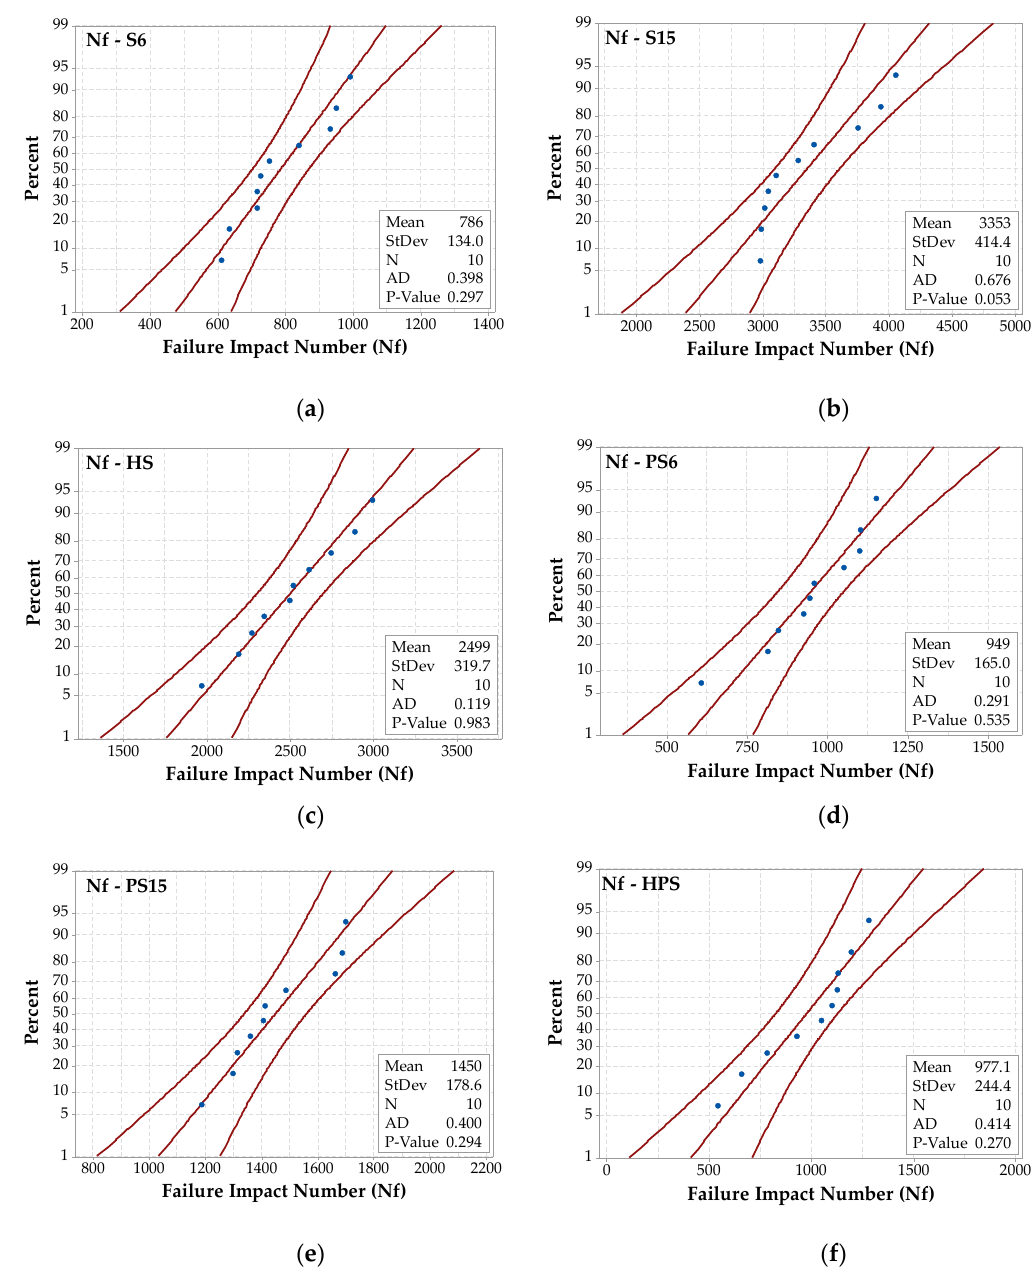
Figure 12. Normal probability plots of the cracking impact number Nf. ( a ) S6; ( b ) S15; ( c ) HS; ( d ) PS6; ( e ) PS15; ( f ) HPS.